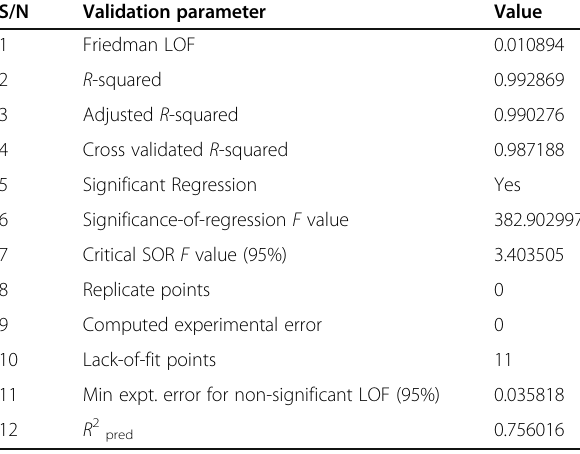
Table 8 Validation parameter for the built model